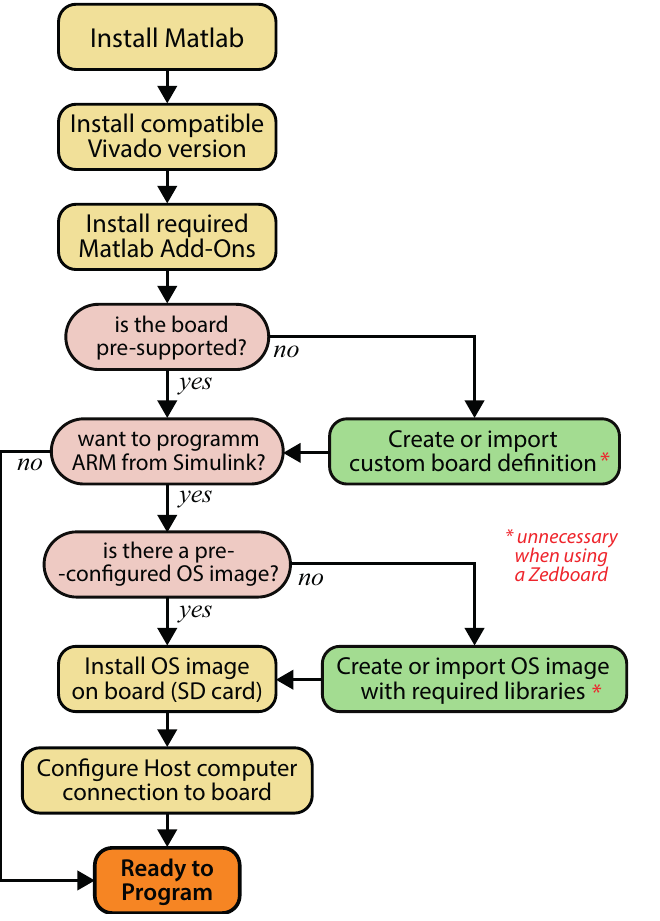
Figure 6. Setup process of the proposed development